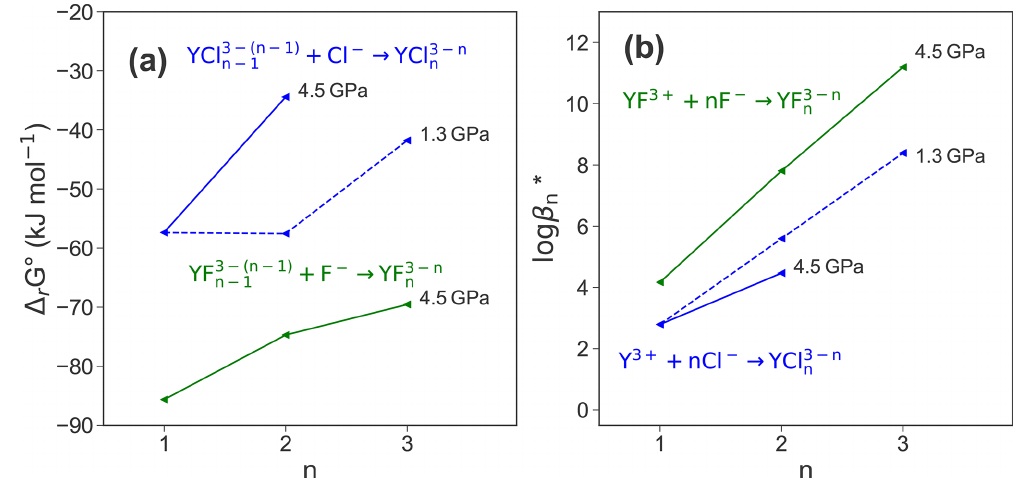
Figure 9. (a) Reaction Gibbs free energy (cid:49) r G ◦ of the different formation reactions; (b) change of the logarithmic stability constant of the different Y − ( Cl , F )